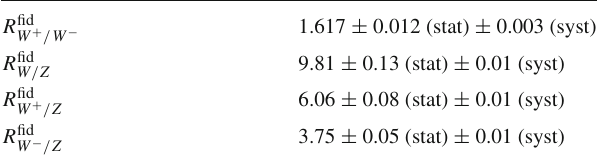
Table 9 Ratios of integrated W and Z production cross